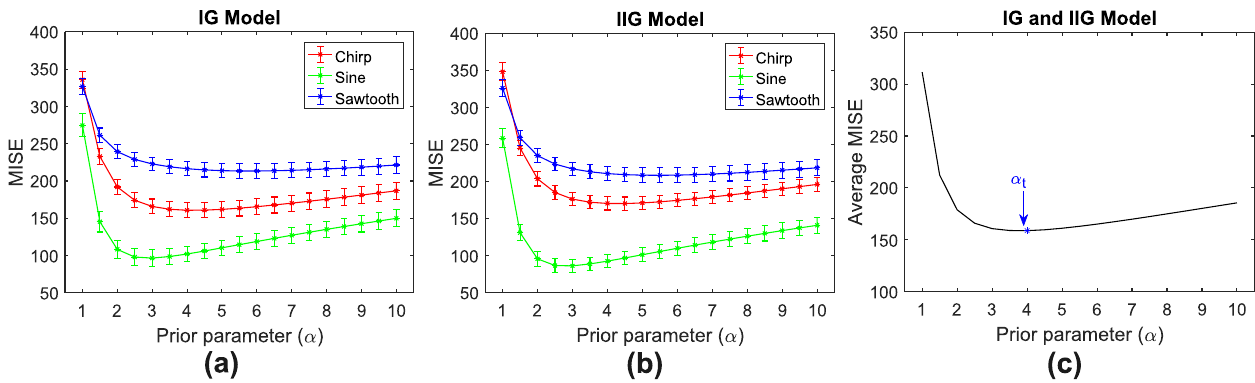
Fig 3. MISE comparison under different values of prior parameter ( α ). (a) MISE values (star marks) and their 95% confidence intervals (vertical bars) for IG model. (b) MISE values (star marks) and their 95% confidence intervals (vertical bars) for IIG model. (c) Average MISE values across 2 models and 3 rate functions. We set α t = 4 as it yields the smallest average